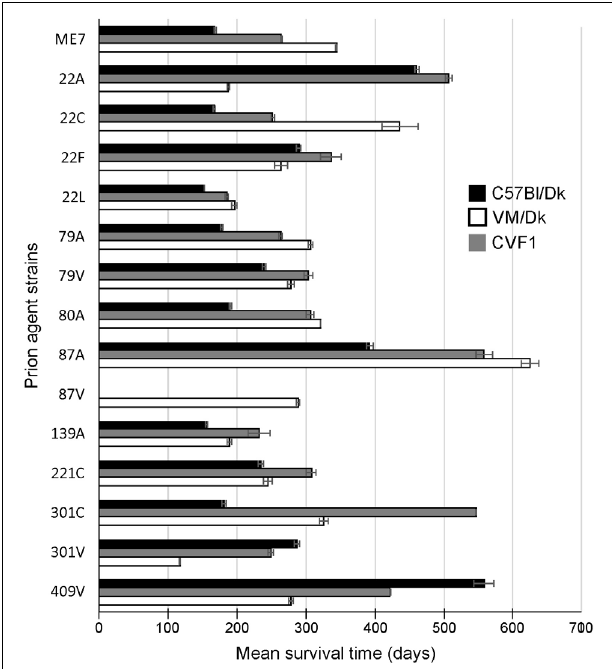
FIGURE 1 | Mean prion disease survival times in laboratory mice infected with a variety of distinct prion agent strains. Groups of C57Bl/Dk ( Prnp -a), CVF1 ( Prnp -a/b) or VM/Dk ( Prnp -b) mice were injected intracerebrally with a variety of distinct prion agent strains ( Table 1 ) and survival times recorded from mice confirmed to have clinical and pathological signs of prion disease. Mean survival times in days ± SEM are displayed for each mouse-passaged prion strain group ( N = 4–31 mice/group, total = 446 mice). Attempted transmissions of the 87 V strain to C57Bl/Dk or CVF1 mice have not produced positive clinical or pathological signs of prion disease in recipient mice up to at least 600 days post